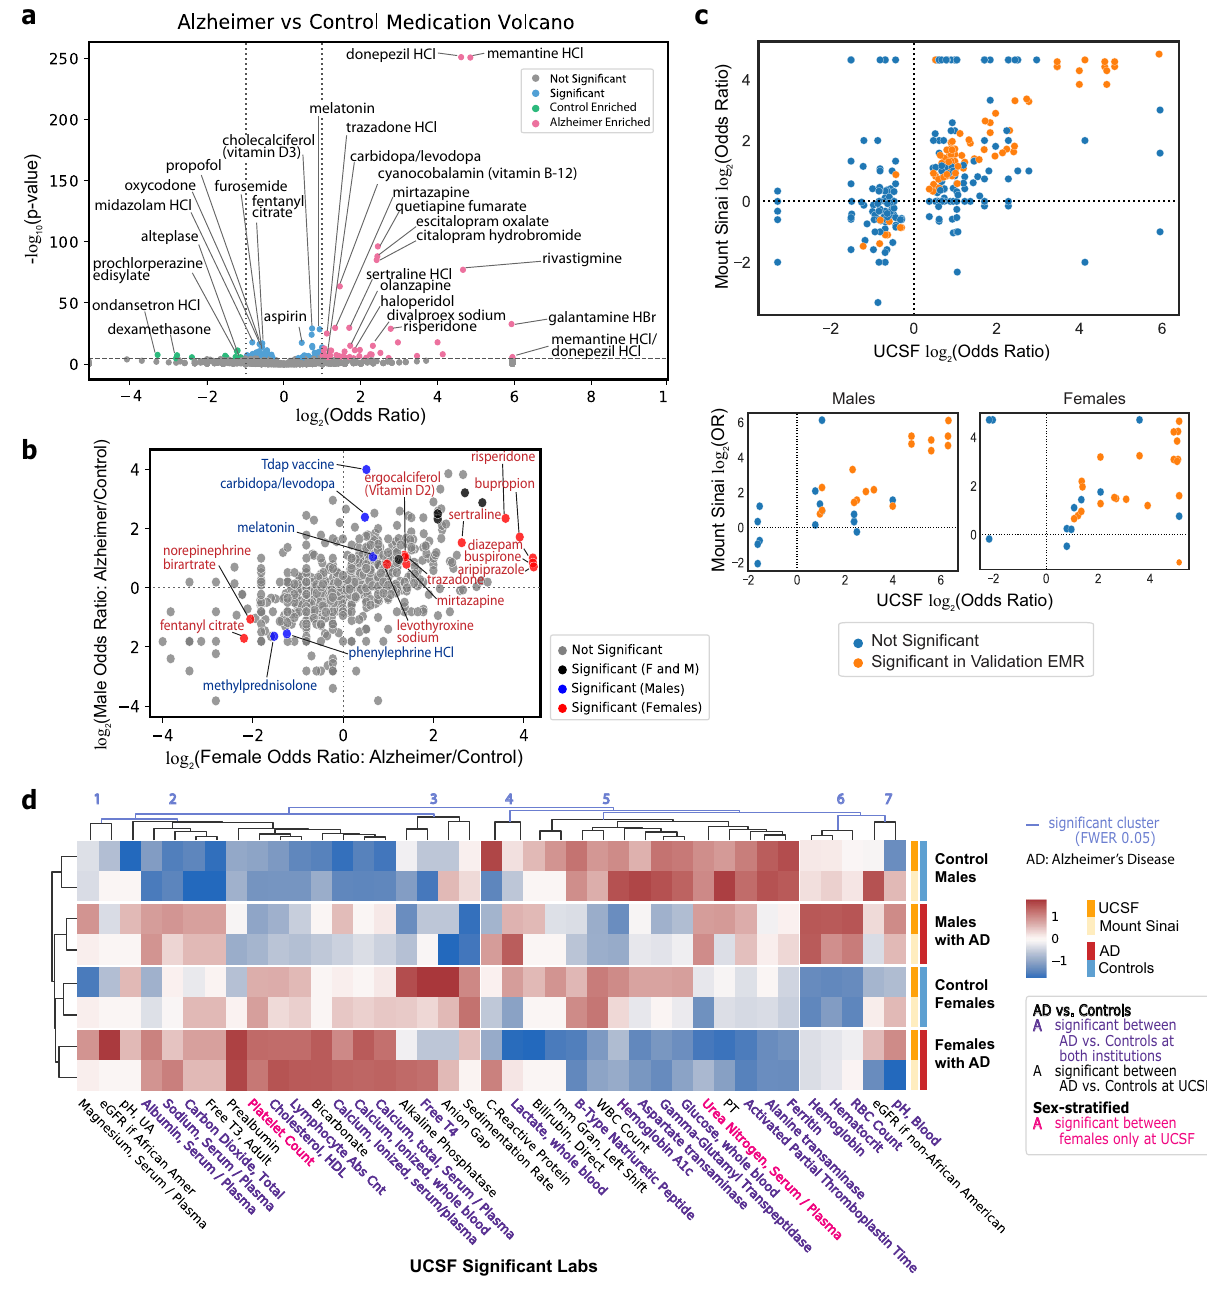
Fig. 6 Medication and lab analysis shows medication enrichments and median lab value differences between AD and control cohorts. a Volcano plot for generic medication names compared between AD and control cohorts using two-sided Fisher ’ s exact or Chi-squared test. p -value cutoff is Bonferroni- corrected ( p -value < 2e − 5) with odds ratio cutoff at 2 for AD-enriched (pink) or 1/2 for control-enriched (green). Remaining signi fi cant diagnoses are in blue. b Log – log plot of generic medication names compared between AD and control cohorts within each sex. The log of the odds ratio for each sex is plotted on the axis, with points colored by signi fi cance based upon two-sided Fisher ’ s exact or Chi-squared test with Bonferroni-corrected threshold of 0.05 if female-only (red), male-only (blue), or both (black). c AD vs control (top) and sex-speci fi c (bottom) odds ratio correlation plots between UCSF and Mount Sinai for medications signi fi cant at UCSF (two-sided Fisher ’ s exact or Chi-squared test with Bonferroni-corrected p -value threshold of 0.05). Each dot represents a medication, and the dots in orange are signi fi cant at Mount Sinai (two-sided Fisher ’ s exact or Chi-squared test with Bonferroni-corrected p -value threshold of 0.05 based on the number of signi fi cant UCSF diagnoses in each group). d Heatmap of lab values fi ltered on signi fi cance at UCSF in AD vs control comparison across sex-speci fi c groups at UCSF and Mount Sinai. Labs are clustered with light blue lines representing signi fi cant cluster breaks (family-wise error rate (FWER)-corrected p -value 0.05). Text color represents signi fi cant labs at both institutions (purple), signi fi cant among females only at UCSF (red), or signi fi cant between AD vs controls at UCSF only (black). Heatmap colors represent z -score of the average median value across the 4 groups at each